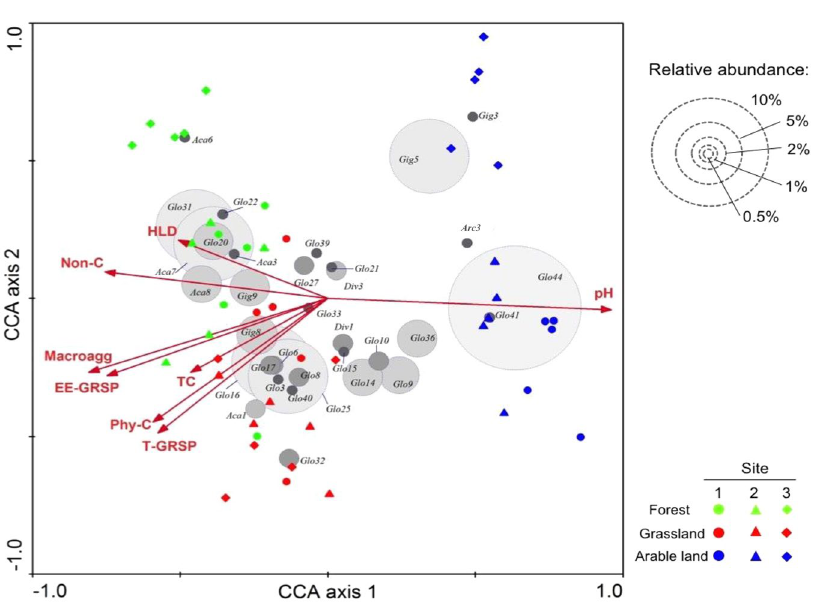
Figure 3. Sample and species plot derived from the canonical correspondence analysis (CCA) of AM fungal communities in soils sampled from three land-use types. The CCA is based on all AM fungal OTUs (84) but only the 34 OTUs that on average represented at least 0.5% of the total amplicon are shown. The relative abundance of each OTU is indicated by dot size. The environmental variables explained 10.9% and 7.1% of the variations in the first two axes. HLD, hyphal length density; T-GRSP, total glomalin related soil protein; EE- GRSP, easily-extractable glomalin related soil protein; Non-C, unprotected C; Phy-C, physically protected C; Macroagg,